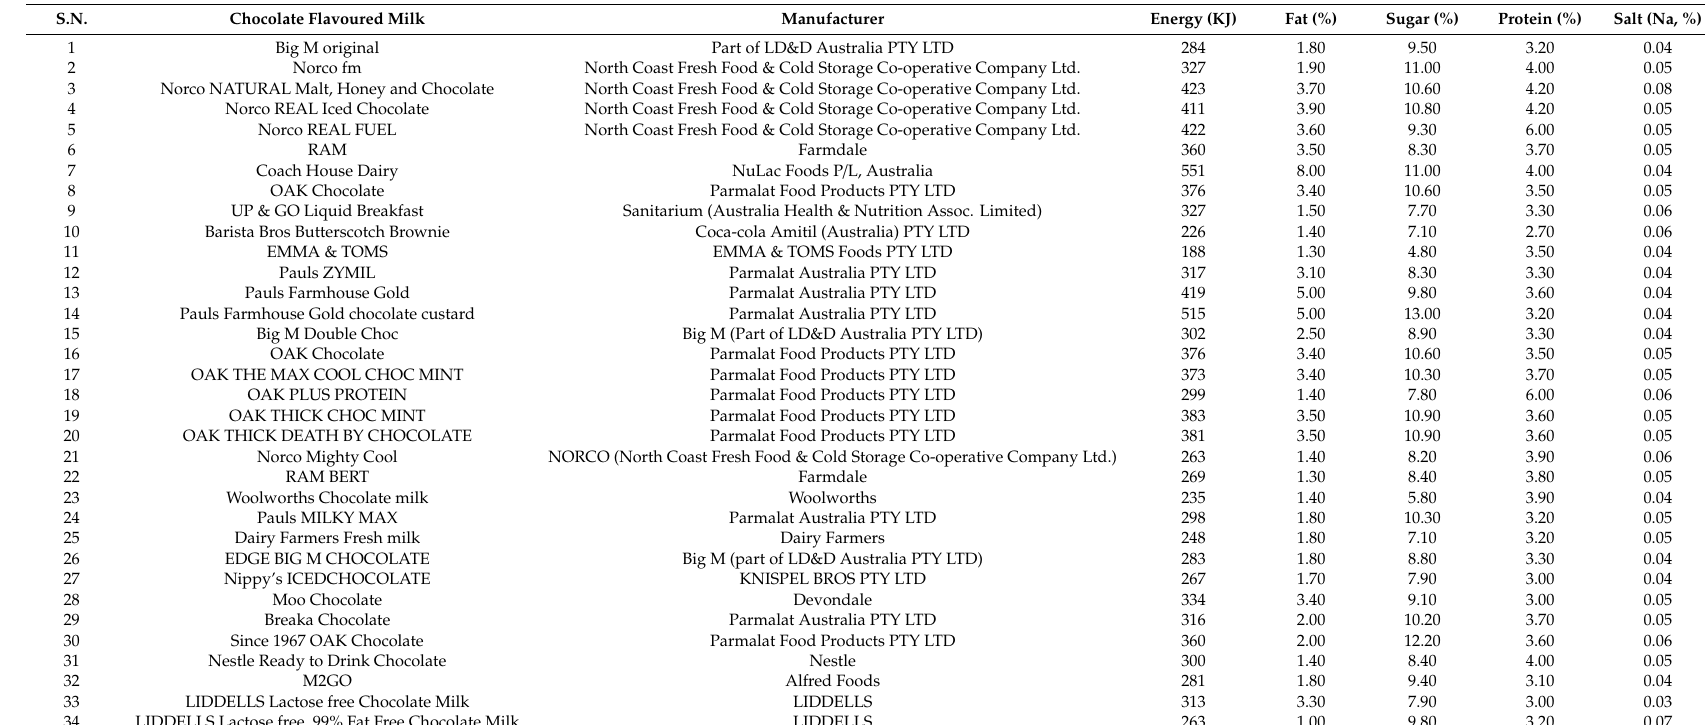
Table 6. Composition of Australian commercial chocolate flavoured